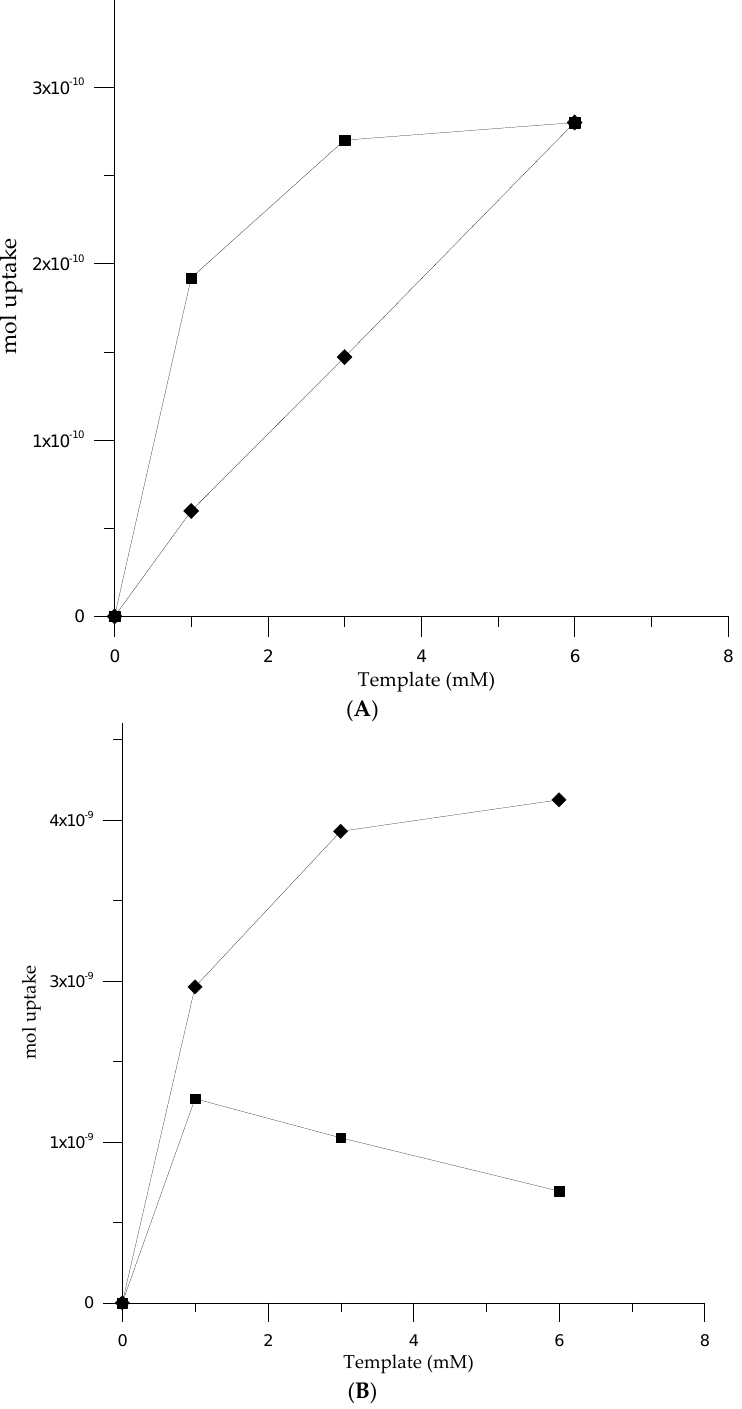
Figure 4. ( A ) Templates hosted by poly-5-ph-DP. Monomer 1 mM in AN + 0.05 M TBAP; WE: Pt-quartz crystal electrode vs. Ag/Ag + RE and Pt-wire AE; scan rate 50 mVs −1 ; ( B ) Templates hosted by poly-5-pOH-DP. Monomer 1 mM in AN + 0.05 M TBAP; WE: Pt-quartz crystal electrode vs. Ag/Ag + RE and Pt-wire AE; scan rate 50 mVs −1 .